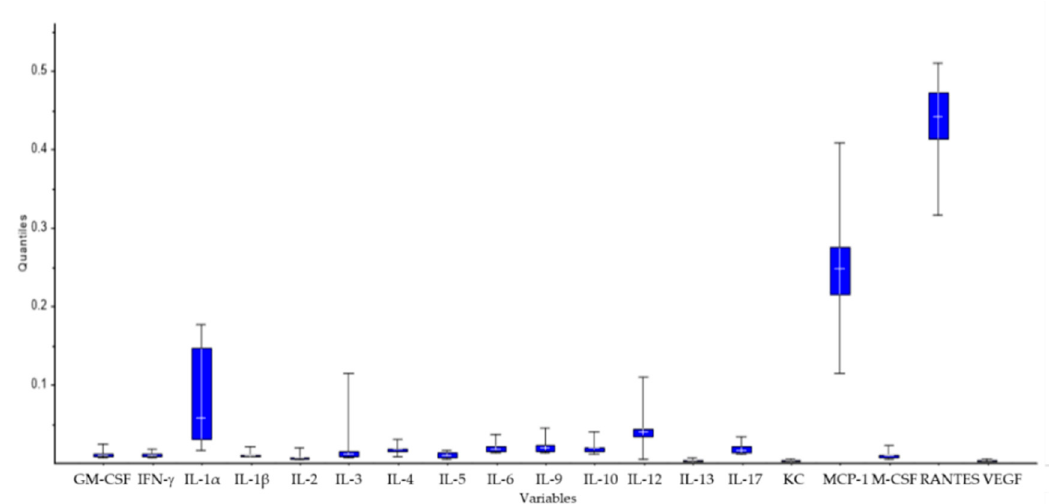
Figure 6. Multivariate analysis on the cytokine profile obtained in Leishmania -infected cocultures of lymphocytes and macrophages in the presence of nucleotides and AHCC.